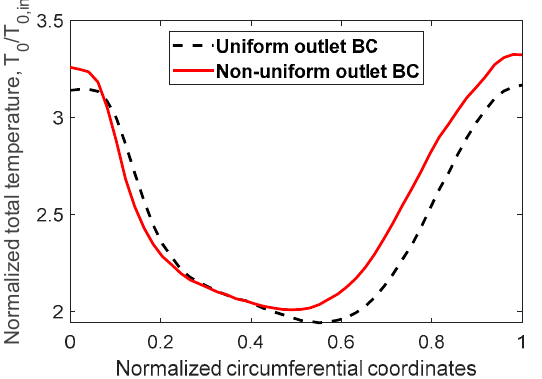
Figure 11. Total temperature circumferential distribution at the combustor outlet mid-span.